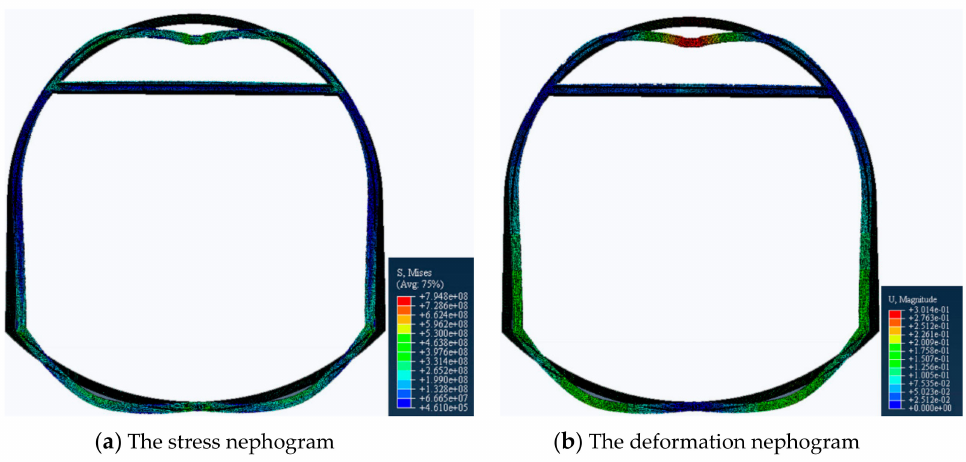
Figure 11. The stress nephogram and the deformation nephogram of RB set II.